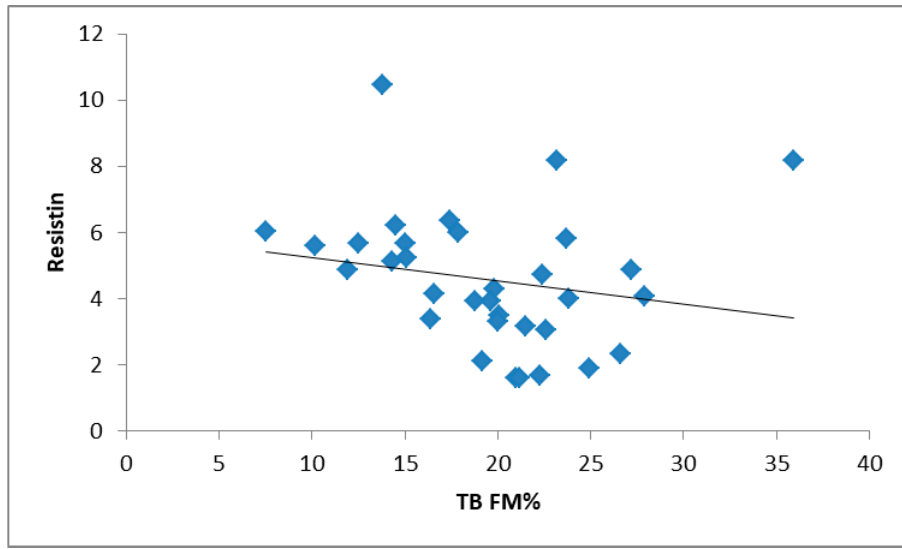
Figure 2. Correlation between resistin and TB FM % in RGs (r = − 0.36; p = 0.040). Table 5. Results of the stepwise multiple regression analysis with BAT as the dependent variable